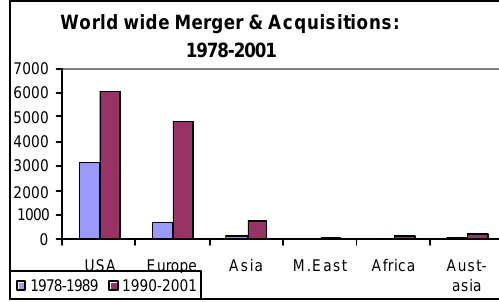
Fig 1: Worldwide Mergers and Acquisitions: